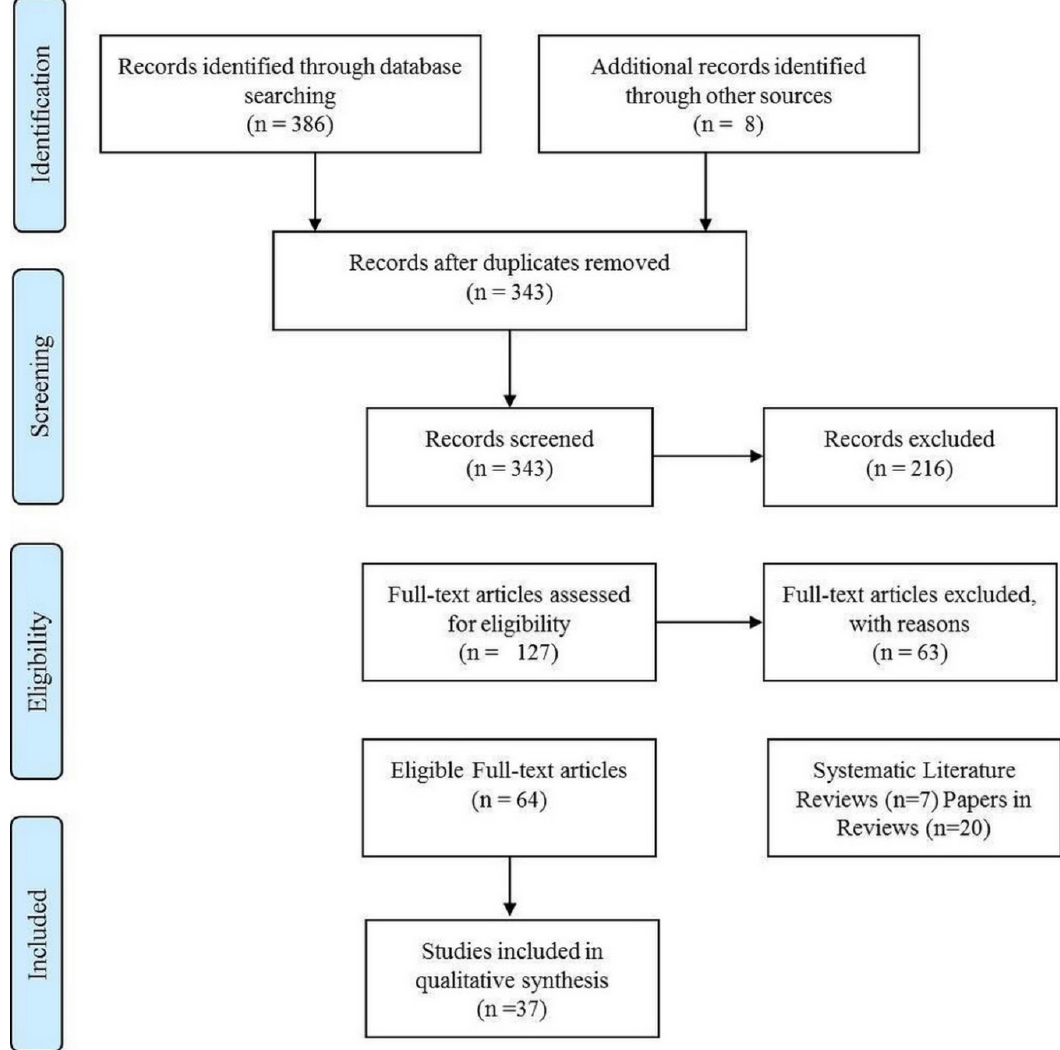
Figure 1. PRISMA 2009 Flow Diagram. Adapted from: Moher D., Liberati A., Tetzlaff J., Altman D.G., The PRISMA Group (2009). Preferred Reporting Items for Systematic Reviews and Meta-Analyses: The PRISMA Statement . PLoS Med 6(7): e1000097. doi:10.1371/journal.pmed1000097. For more information, visit www.prisma-statement.org/. Table 4. Higher-order cognitive functions and associated lower-order cognitive functions used in this review.